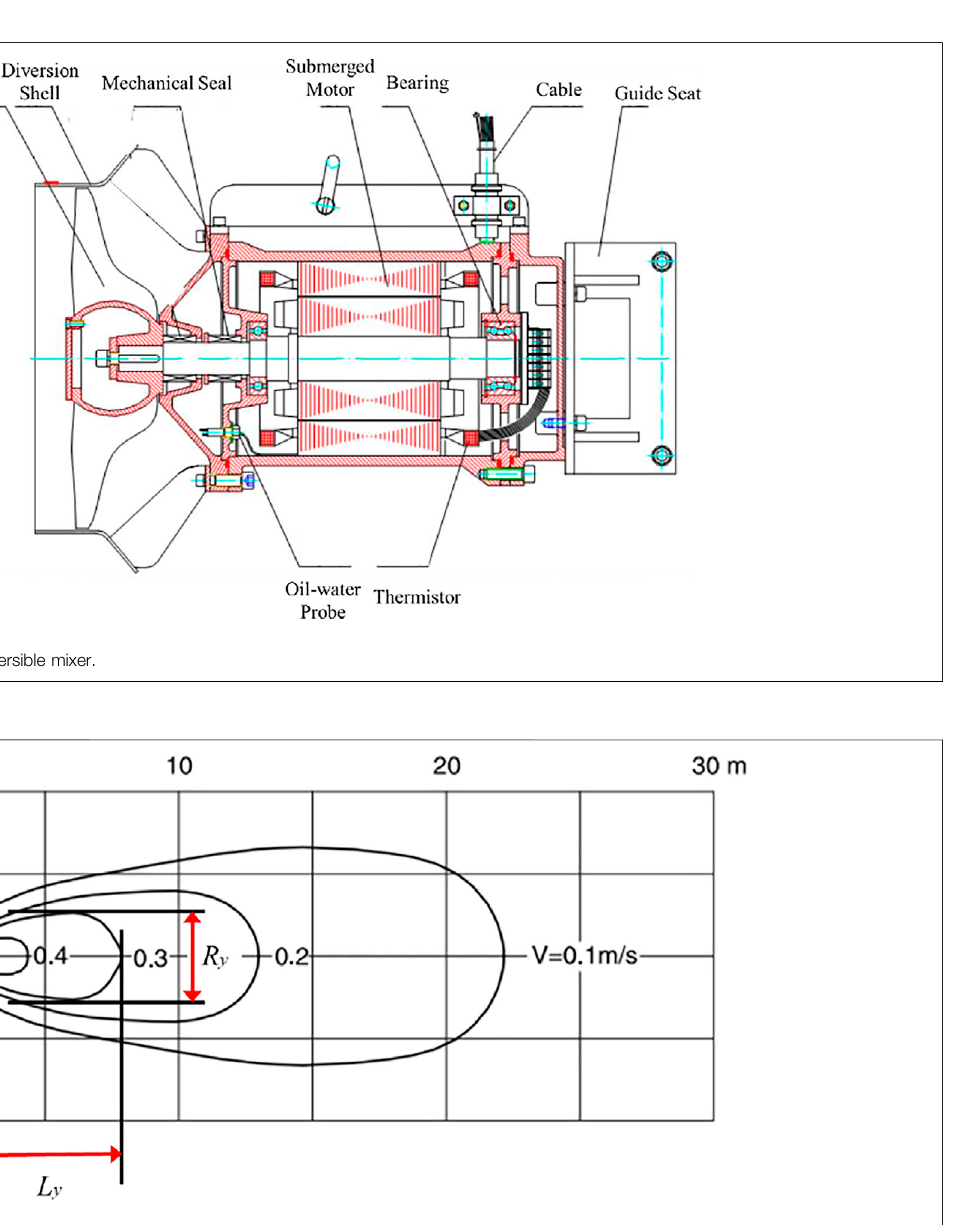
FIGURE 3 | Velocity fl ow fi eld